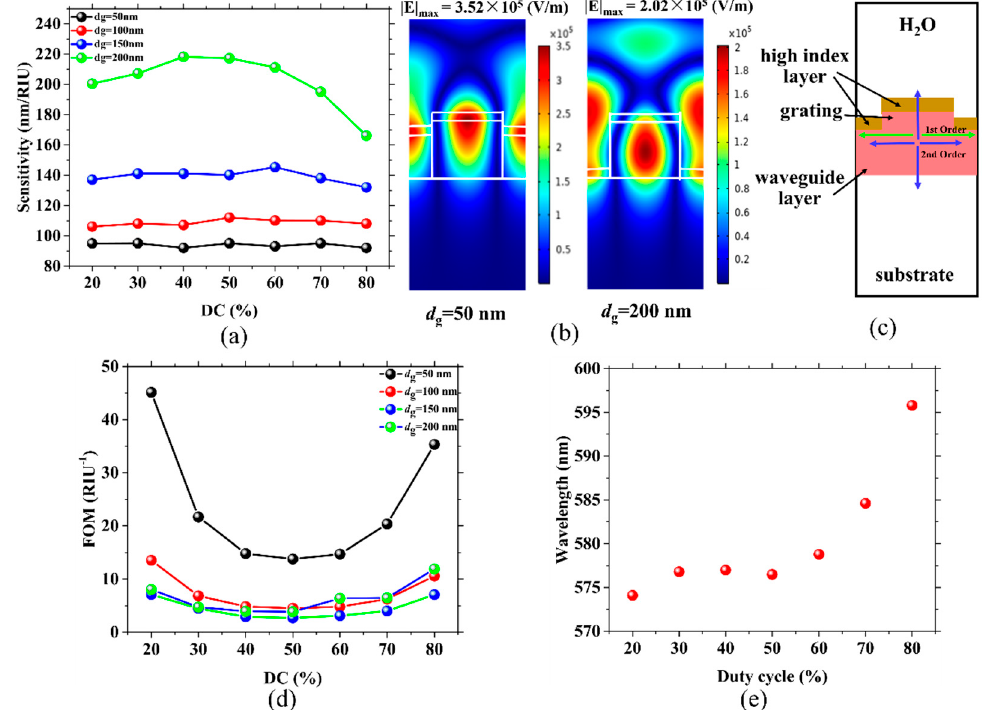
Figure 2. ( a ) Sensitivity versus d g and DC; the same colored points represent the same values of d g . ( b ) Electric field distributions of the resonant wavelength, which are 627.5 and 577.8 nm for sensors with d g = 50 nm ( d wg = 0 nm) and d g = 200 nm ( d wg = 0 nm), respectively. In both cases n c = 1.33, DC = 60% and the period of the grating ( Λ ) = 400 nm. ( c ) Schematic diagram of the waveguide structure. ( d ) The figure of merit (FOM) for various d g and DCs; the same colored balls represent identical values of d g . ( e ) Calculated resonant wavelength versus duty cycle for a d g of 200 nm.